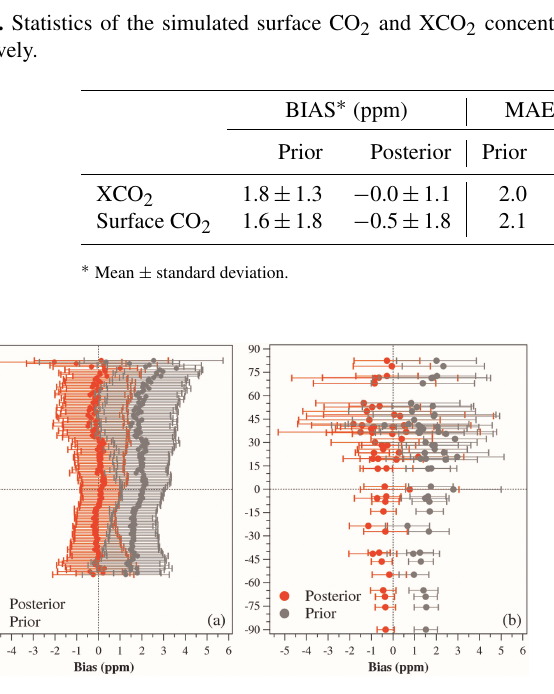
Figure 3. BIAS at different latitudes. Panel a shows the BIAS be- tween the simulated and retrieved XCO 2 , and panel b shows the ones between the simulated and observed CO 2 mixing ratios. Error bars represents the standard deviations of the biases at each latitude and each site in panels (a) and (b) , respectively.